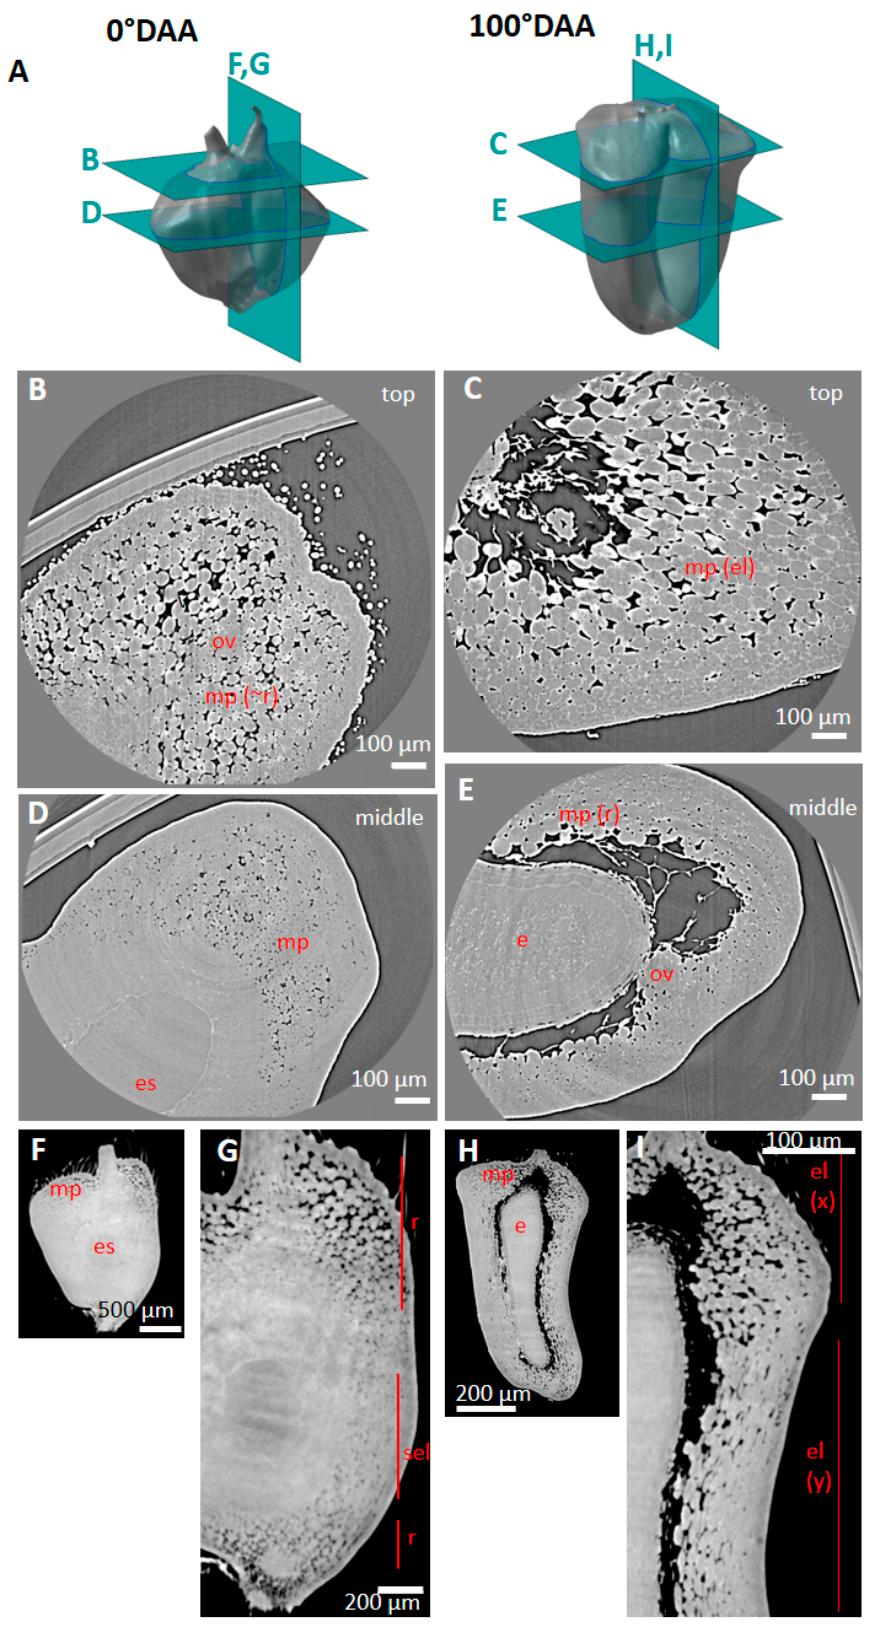
Figure 9. Spatial and developmental variability in mesocarp cell orientation observed along the caryopsis longitudinal axis. ( A ) localization of virtual sections. ( B , C ) Representative high-resolution tomography image (transverse virtual section) at the top of a wheat caryopsis harvested at anthesis